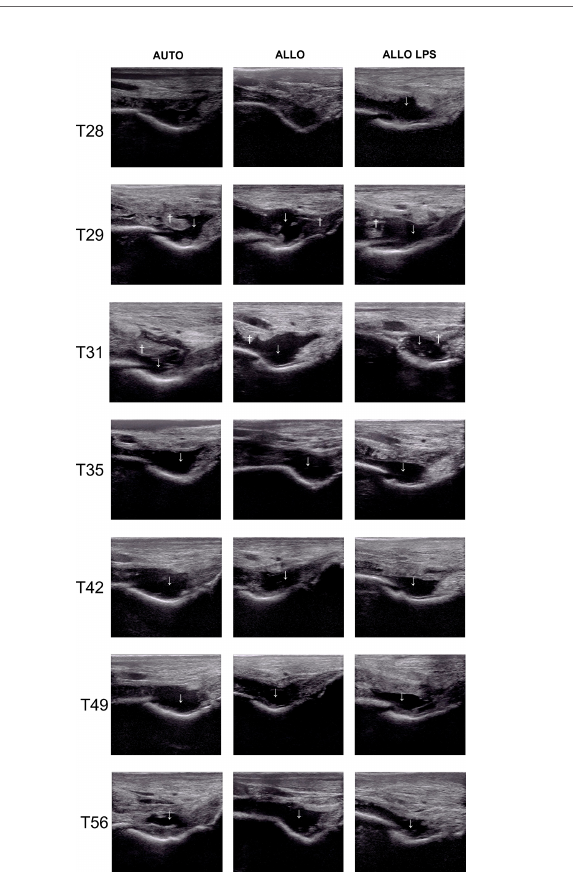
FIGURE 5 | Ultrasonographic aspect of tibiotarsal joints before and after the second MSC injection. Extended synovial effusion ( ↓ ) and synovial membrane hyperplasia ( † ) can be noticed in all groups.